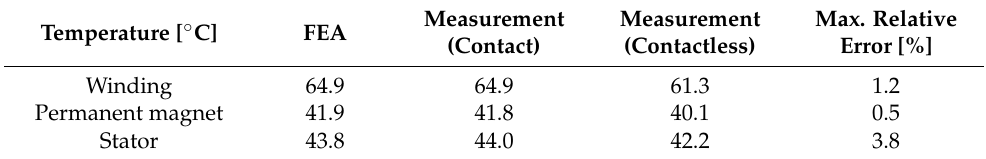
Table 2. Comparison of the calculation and measurement—non-rotating machine.